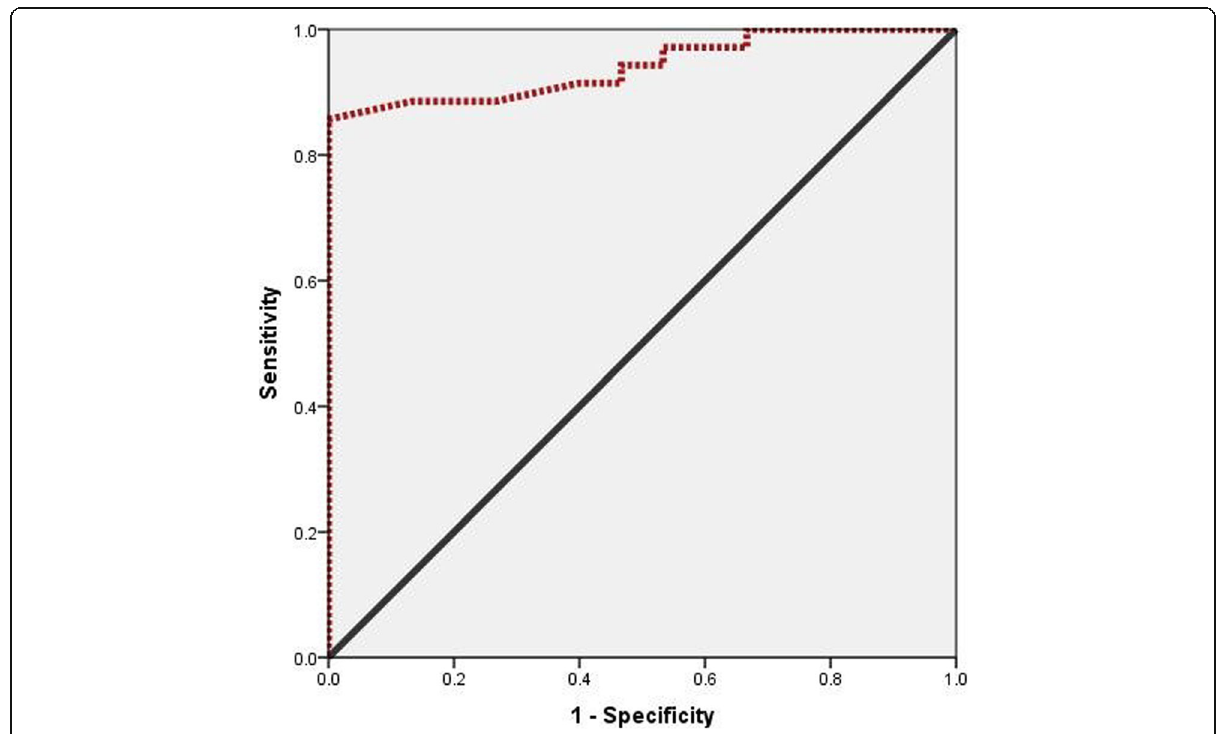
Fig. 2 ROC curve analysis for the ADC value